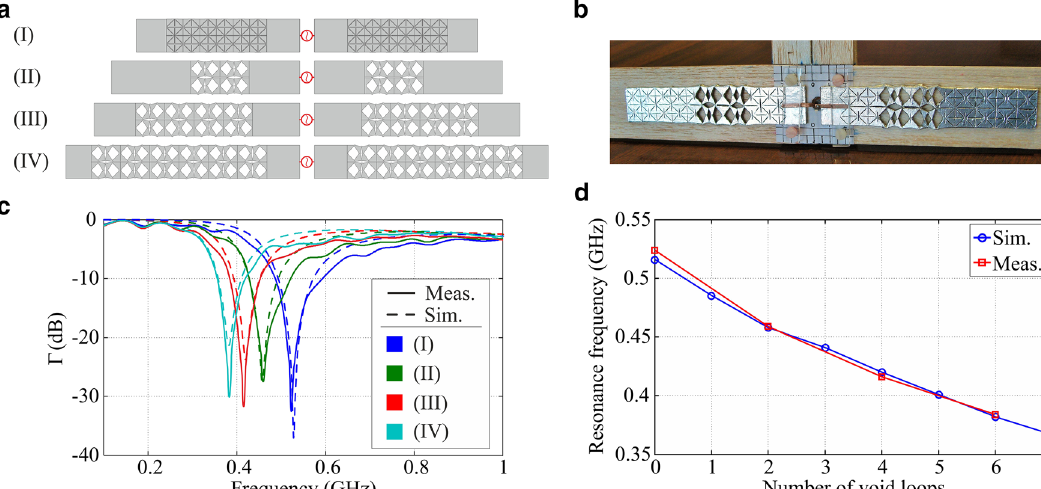
Figure 3. ( a ) Sketches of realized dipole model. ( b ) Sample prototype in the measurement setup. ( c ) Simulated and measured reflection coefficient of the tuneable dipole in the sample configurations of variable extension shown in subfigure ( a ). ( d ) Comparison of the simulated and measured range of